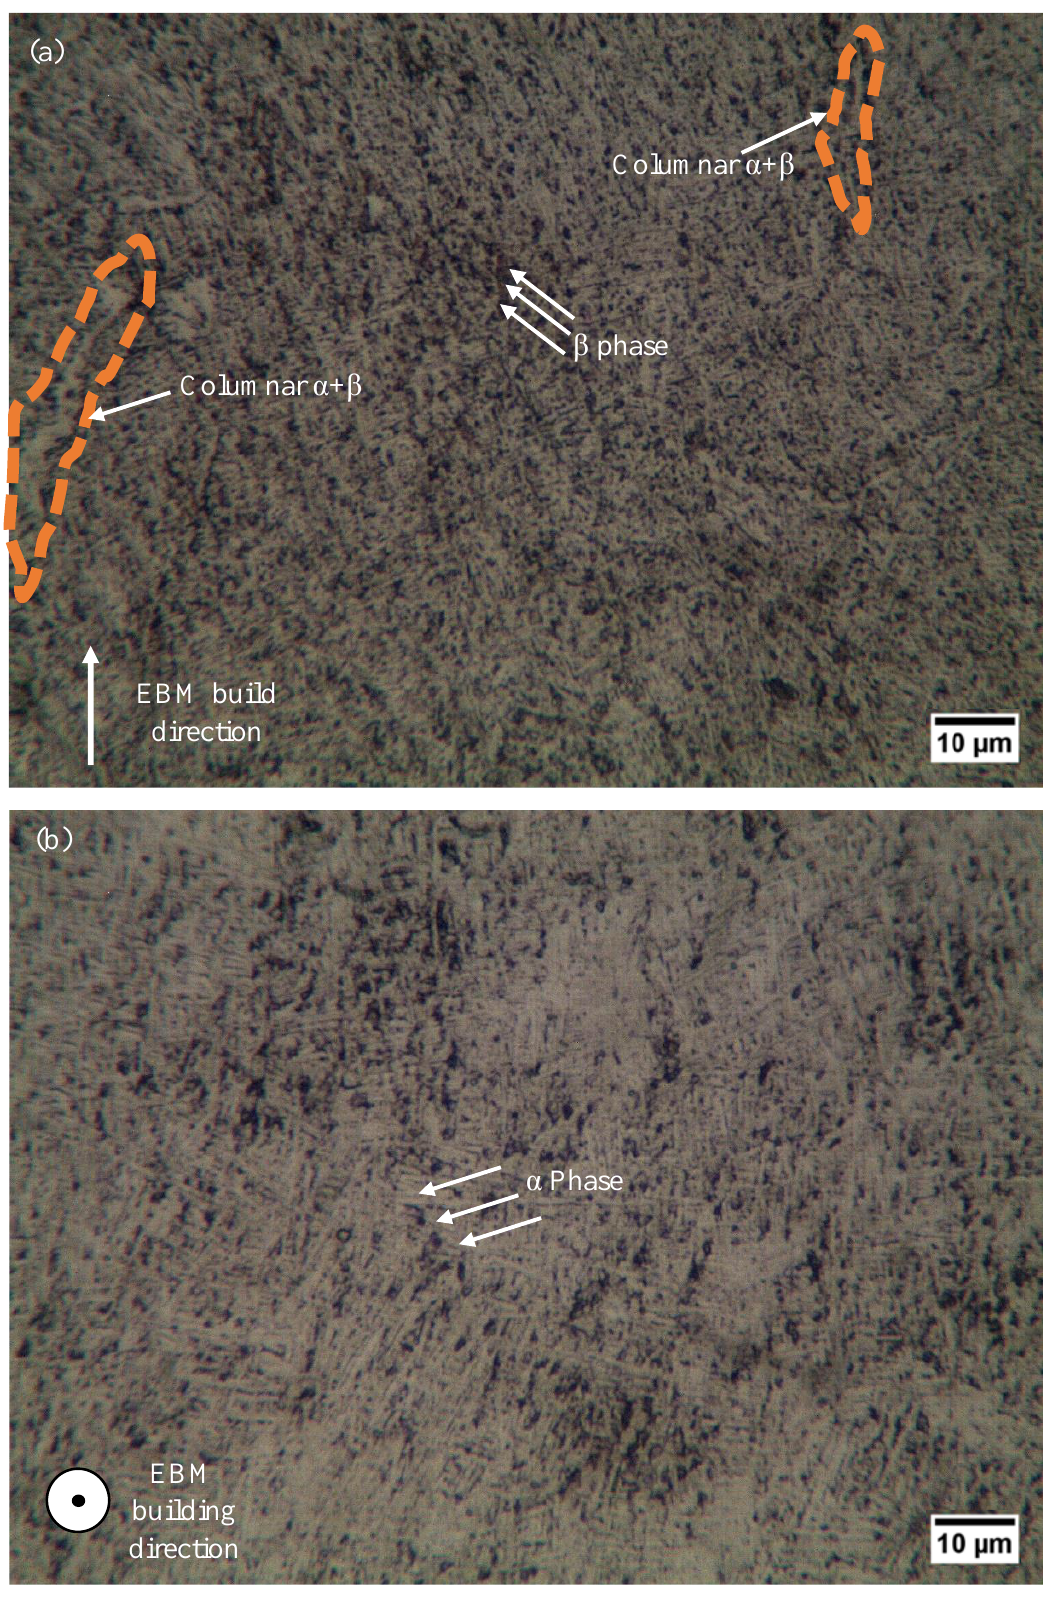
Figure 8. Microstructural images of the cross-sections shown in Figure 1 for the EBM Ti6Al4V part: ( a ) cross-section AA’; ( b ) cross-section BB’.